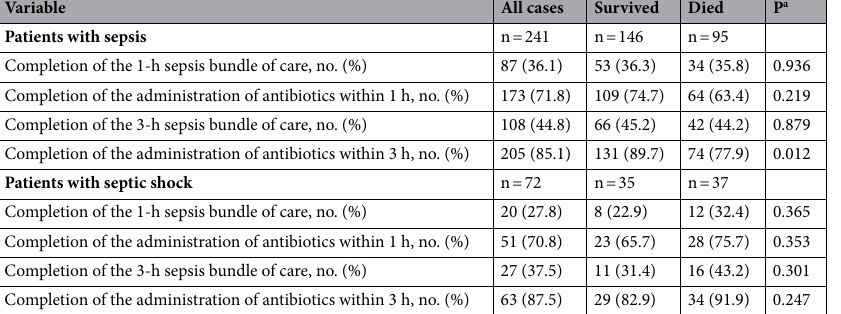
Table 5. Completion of the sepsis bundle of care and the administration of antibiotics according to the hospital survivability of patients with sepsis and septic shock. no. number. a Comparison between survived and died patients with